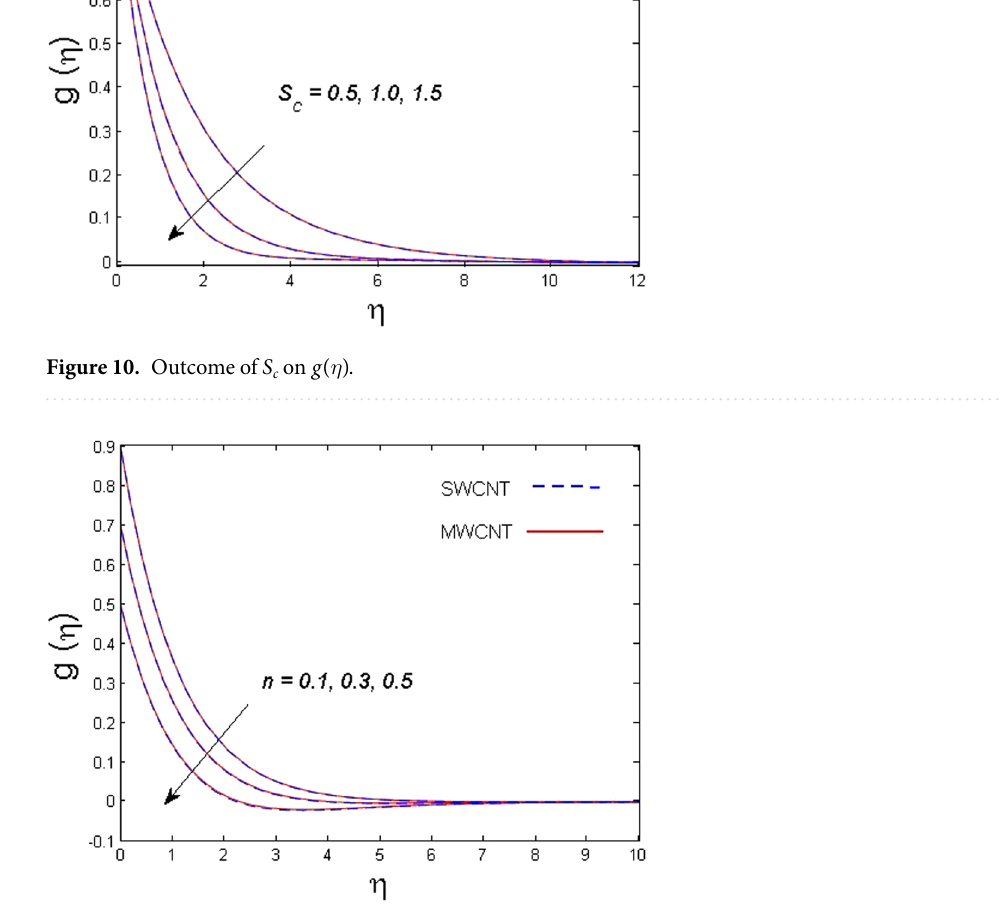
Figure 11. Outcome of n on g ( ) η